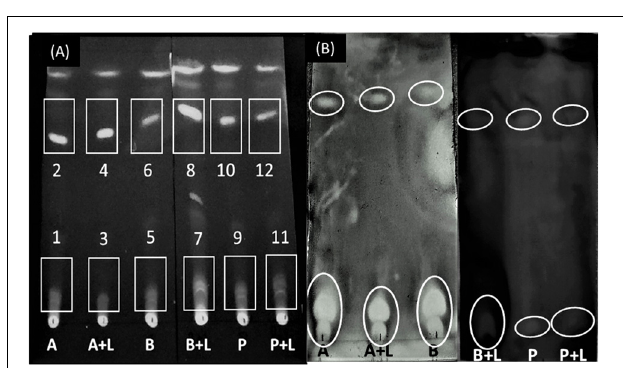
FIGURE 4 | Separation of bioactive compounds against L. monocytogenes . (A) Thin Layer Chromatogram of chloroform-extracted samples using chloroform as a mobile phase. The numbers identify the spots where inhibition of L. monocytogenes was observed. (B) Direct bioautography test using 3-(4, 5-dimethylthiazol-2-yl)-2, 5-diphenyl tetrazolium bromide (MTT) dye. A, A. chroococcum ; B, B. megaterium; P, P. fluorescens ; L, L. monocytogenes . Inhibition zones have been